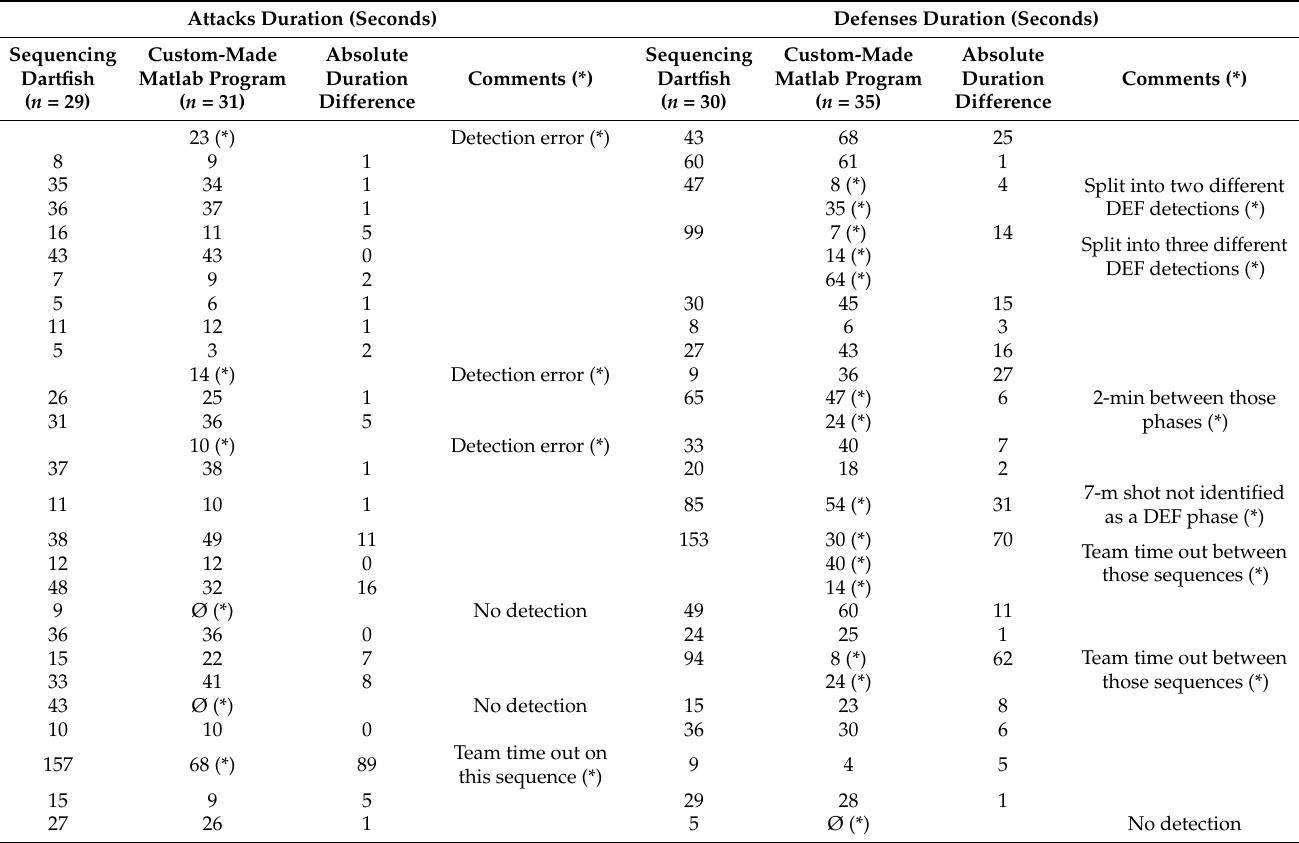
Table A4. Second half of the second match of the data validation set. Comparisons between Dartfish sequencing and the custom-made Matlab